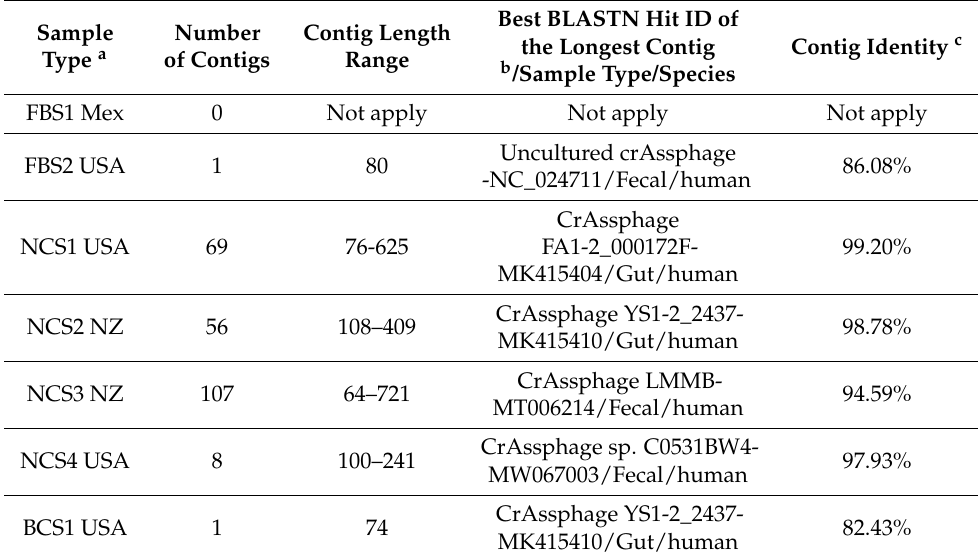
Table 2. Characterization of retrieved CrAssphage contig